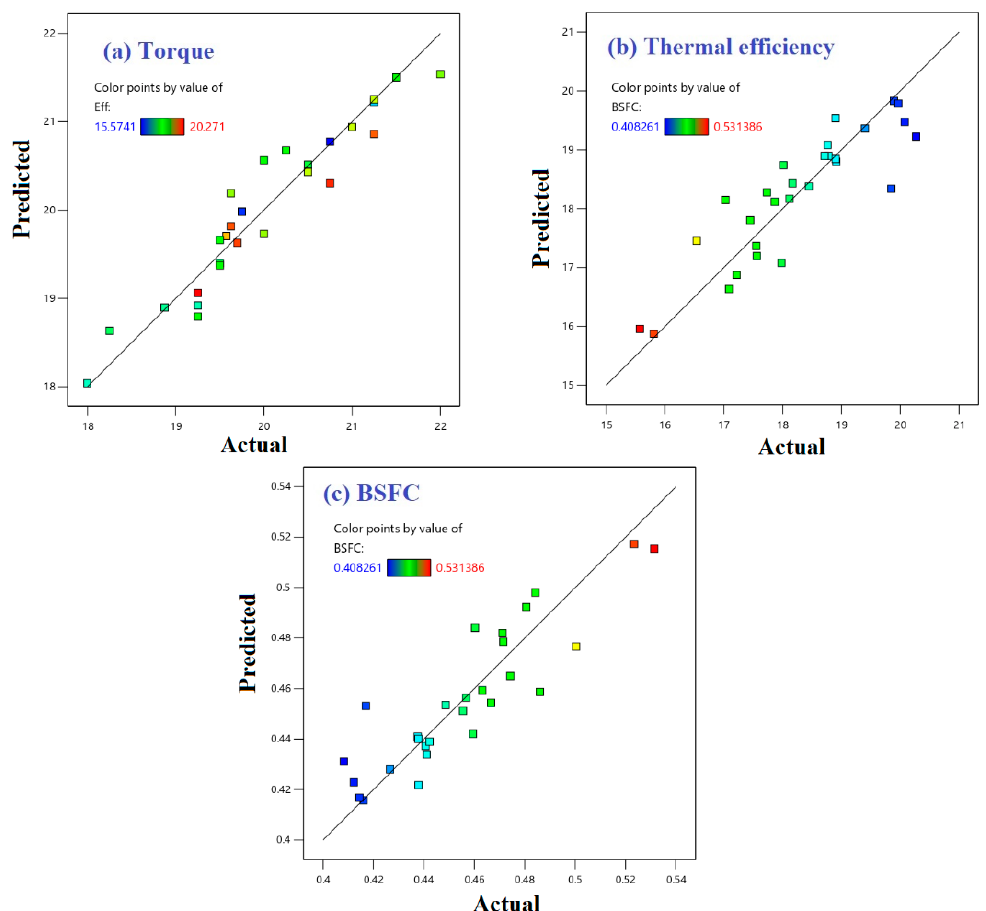
Figure 13. Comparison of the predicted and actual values of output responses.